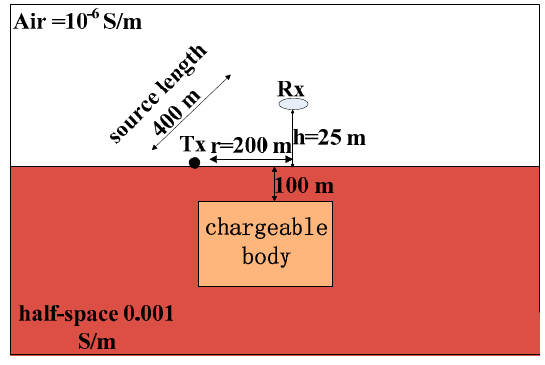
Figure 8. Three-dimensional (3D) model with IP effect.